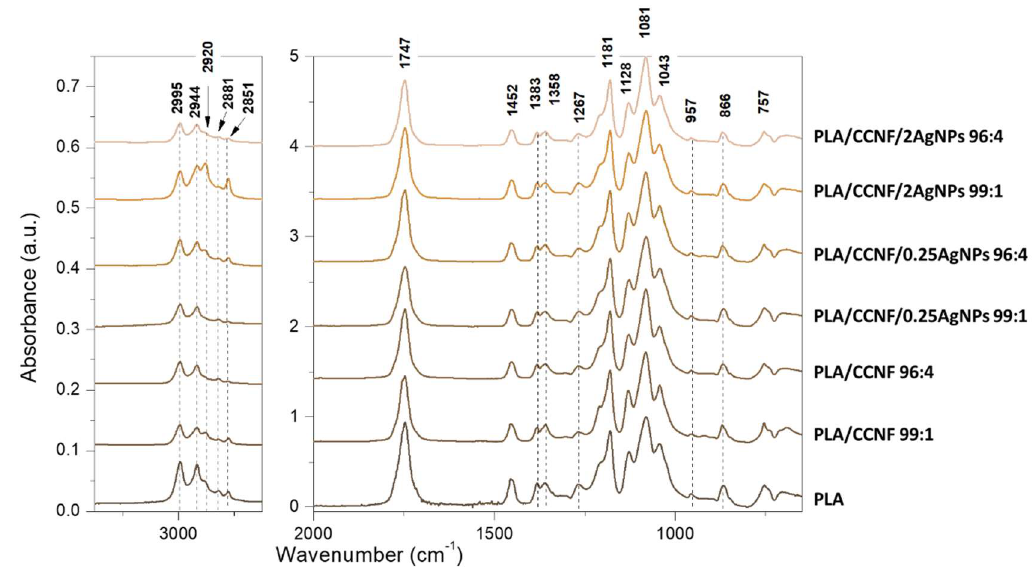
Figure 2. FTIR spectra of obtained nanocomposites of PLA and CCNF with or without AgNPs in concentration 0.25 mM and 2 mM presented in the range 3300–650 cm −1 , with a break from 2750– 2000cm −1 .